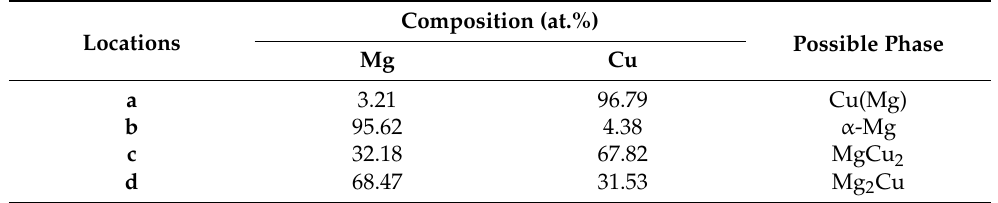
Table 2. EDS analysis results of locations in Figure 2a,b.